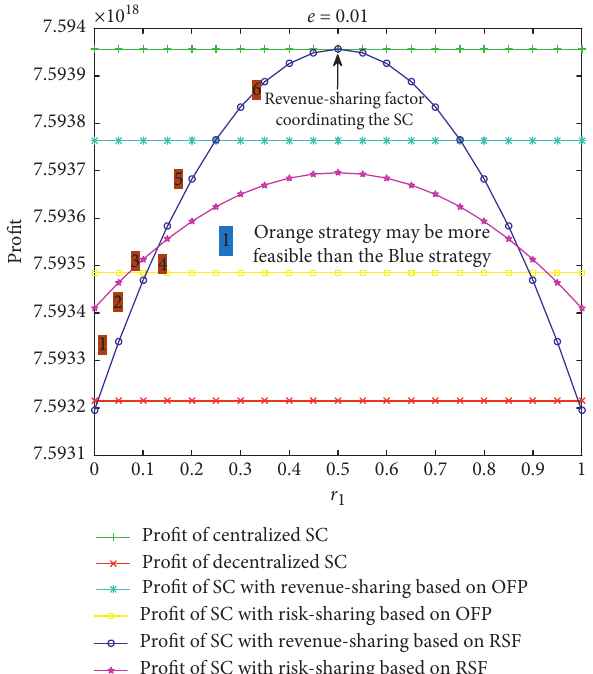
Figure 6: The optimization strategy cannot be completed in one step, but step by